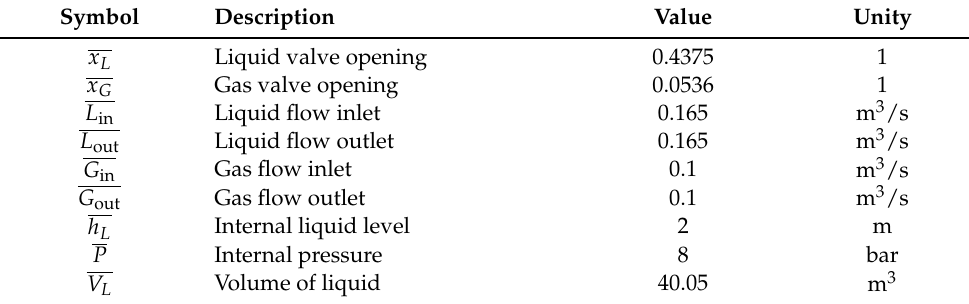
Table 2. Biphasic oil separator steady state